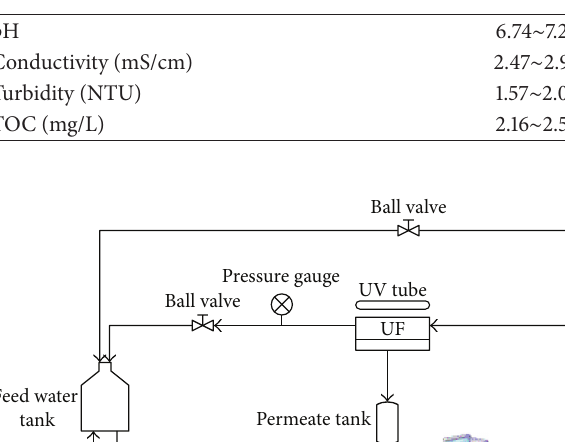
Table 1: Water quality of secondary effluent.